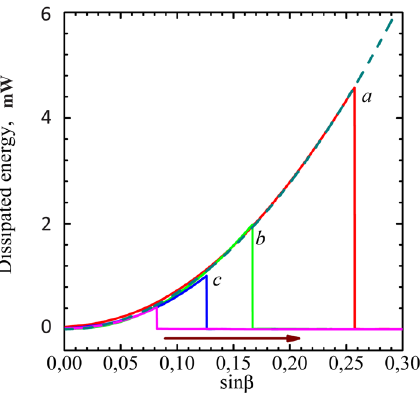
Figure 3. The dissipated energy as a function of angle of deflection for the 0.5 mm disc. The fitting lines correspond to square